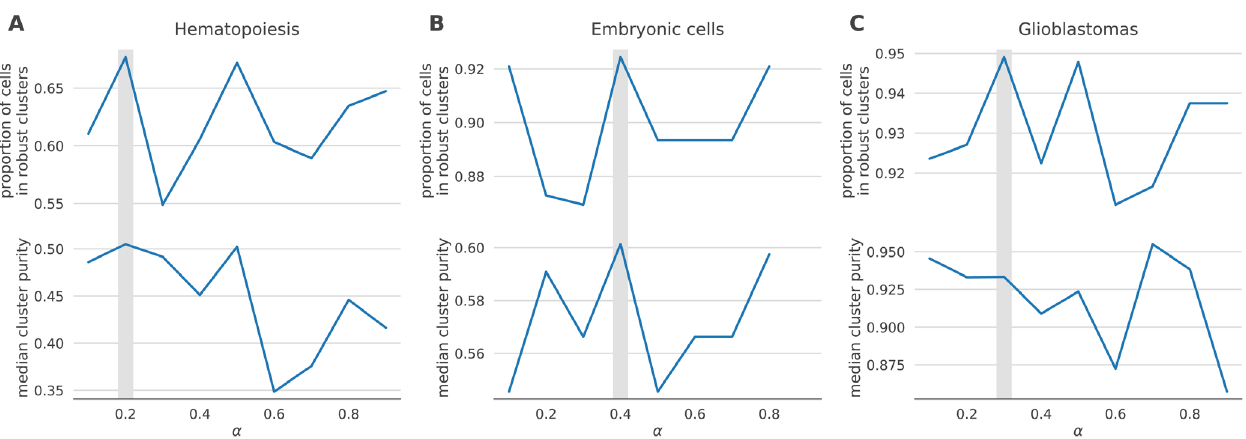
Figure 12. the proportion of cells in robust clusters, and cluster purity for those robust clusters, for a range of alpha values, shows that picking the alpha with the highest proportion in robust clusters also picks the alpha with the highest cluster purity. A ) hematopoietic stem/progenitor cells B ) embryonic cells, C ) glioblastomas. The online version of this figure is interactive.